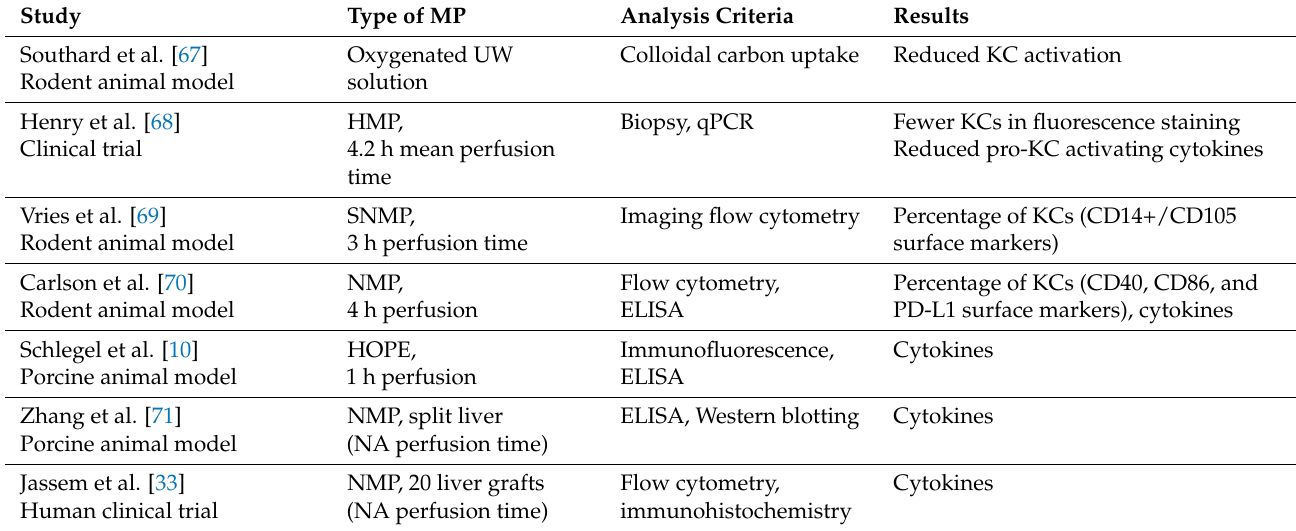
Table 1. Effects of MP on